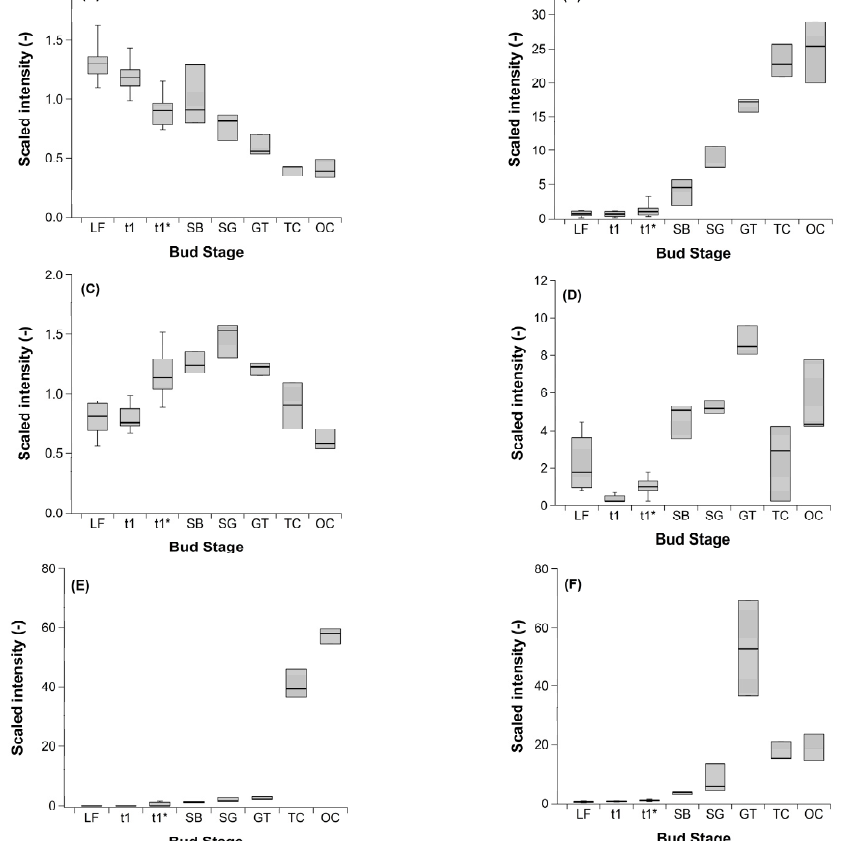
Figure 4. Selected examples of ‘data trends’ in the untargeted profiling of sweet cherry buds cv. ‘Summit’. ‘Total leaf fall’ (LF), endodormancy release (t 1 ), beginning ontogenetic development (t 1 *) ‘swollen bud’ (SB), ‘side green’ (SG), ‘green tip’ (GT), ‘tight cluster’ (TC), and ‘open cluster’ (OC). Sample size for the stages LF, t 1 , and t 1 * ( n = 6), for the stages between SB and OC ( n = 3). ( A ) steady decrease: catechin, ( B ) steady increase: 1-linolenoylglycerol (18:3), ( C ) steady rise and decline: 1-linolenoyl-digalactosylglycerol (18:3), ( D ) varies with growth stage: gamma-glutamylvaline, ( E ) undetectable, low level, high level: cytidine 2 ′ or 3 ′ -monophosphate (2 ′ or 3 ′ -CMP), ( F ) peak at one stage: 2,3-dihydroxyisovalerate.